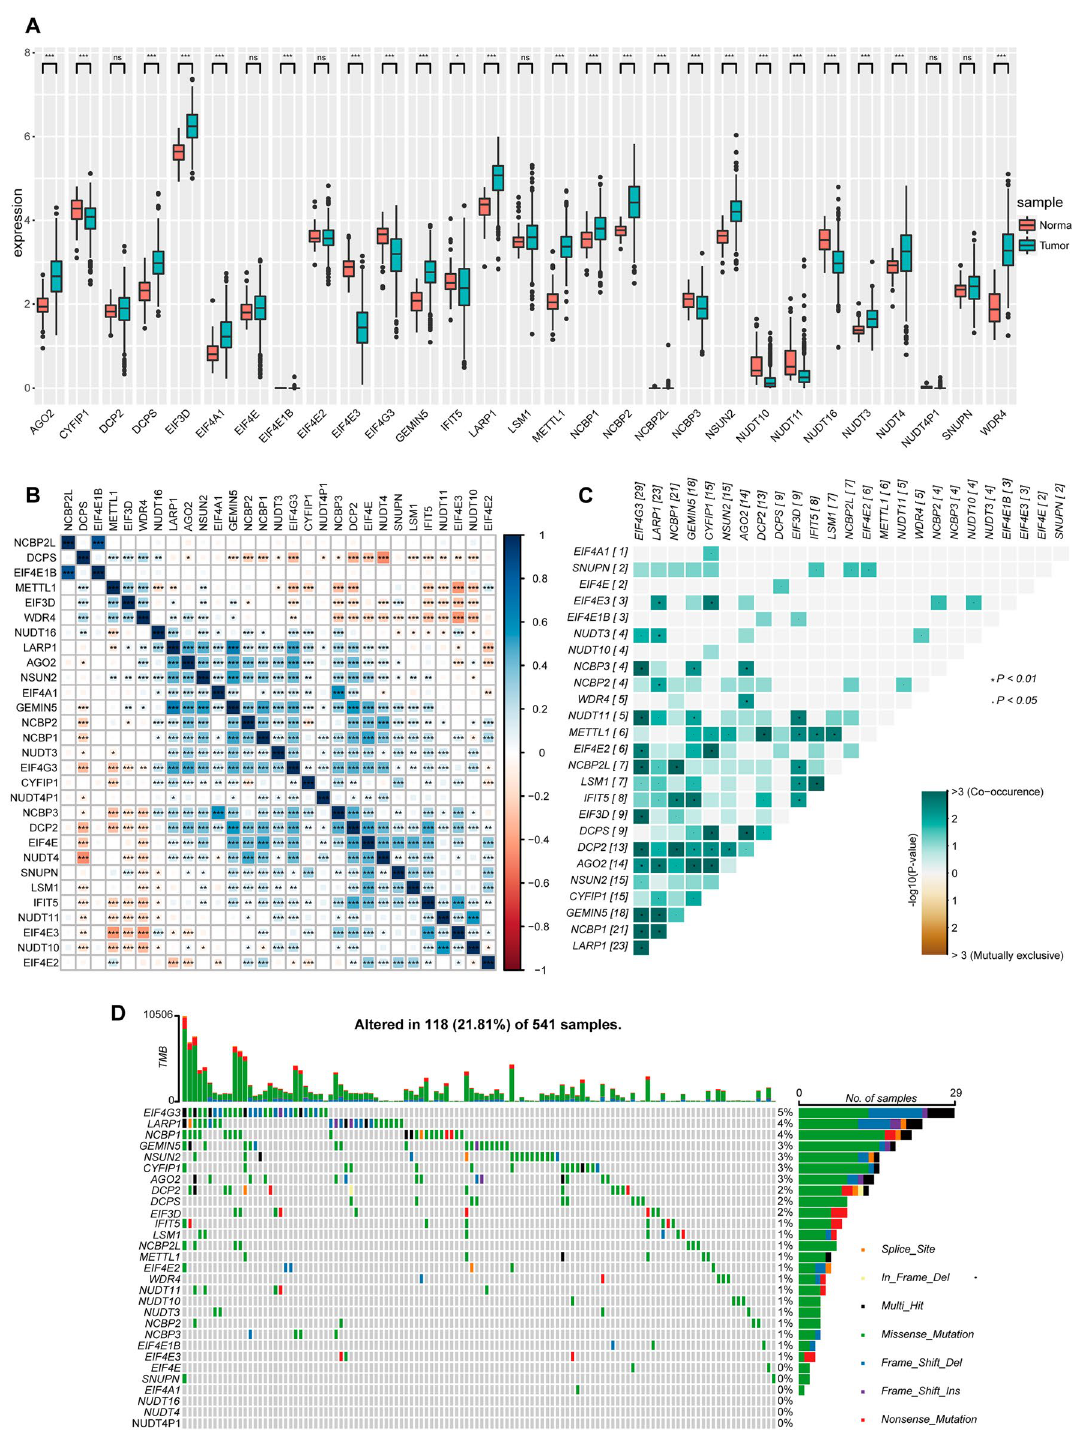
Figure 1. CRC patient m 7 G-related genes expression and mutational profiles. ( A ) The expression of 29 m 7 G- associated genes in normal and CRC patient tumor tissue samples. ( B ) Correlation heat map of expression between m 7 g genes, plotted using the corrplot function in the corrplot package of the R language (version 4.1.2, https:// www.r- proje ct. org/). ( C ) The co-occurrence and mutual exclusivity of these 29 m 7 g-related genes after mutation were plotted using the somaticinteraction function in the maftools package of the R language (version 4.1.2). ( D ) Waterfall plots representing the mutational characteristics of these 29 m 7 g-related genes were drawn using the oncoplot function in the maftools package of the R language (version 4.1.2). *P < 0.05; **P < 0.01; ***P <